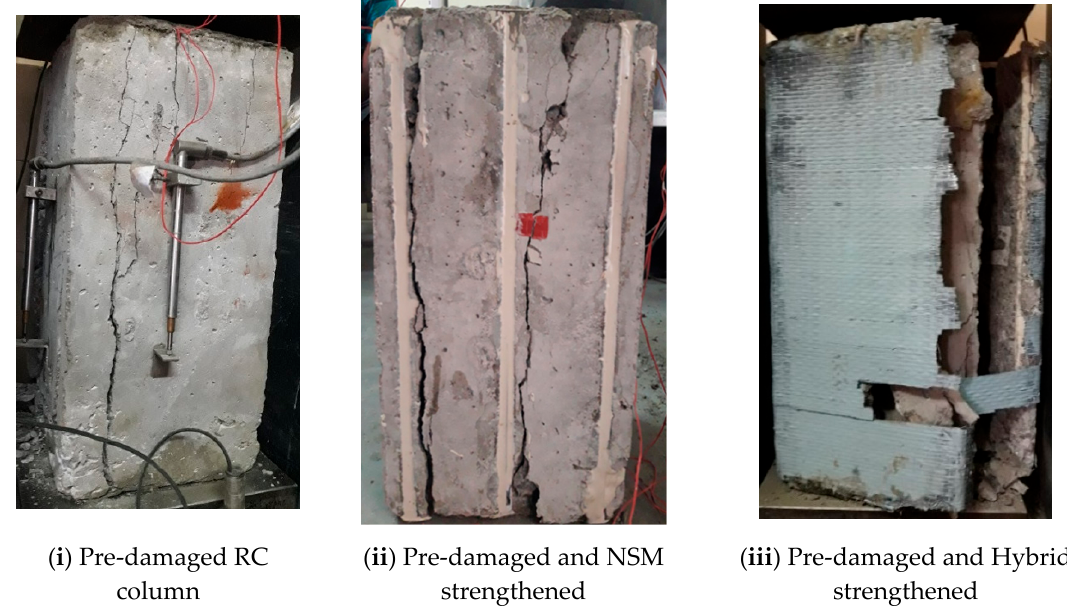
Figure 10. Failure mode of pre-damaged RC specimens after strengthening.